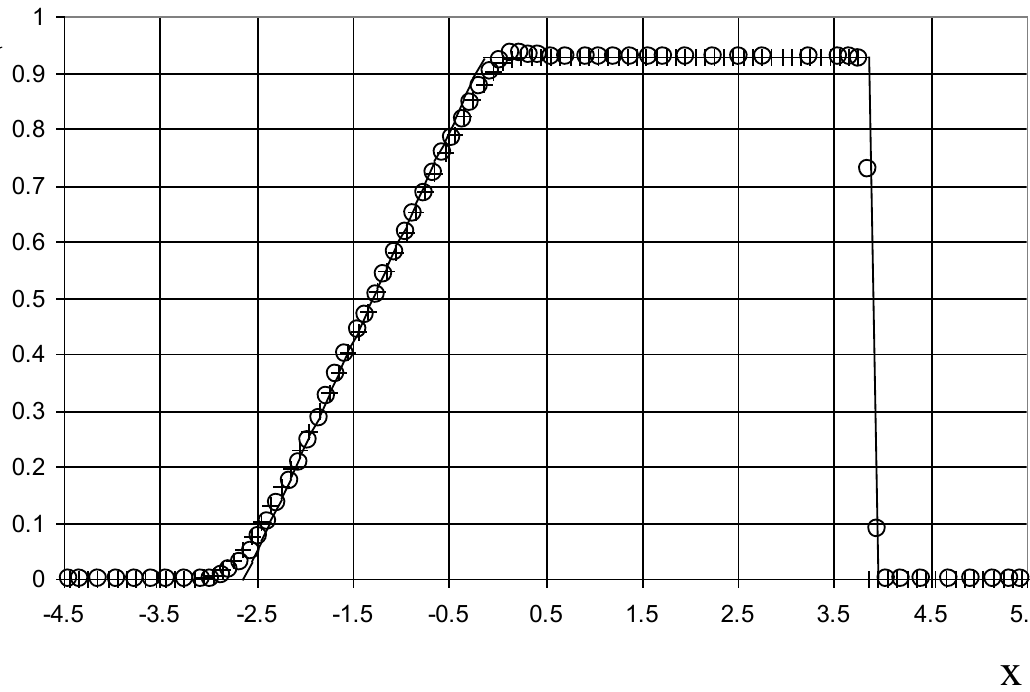
Figure 12. Velocity plot for the shock-tube problem of Sod: the exact solution (line), the ULT1C scheme of Harten (circle), and the present method (cross).